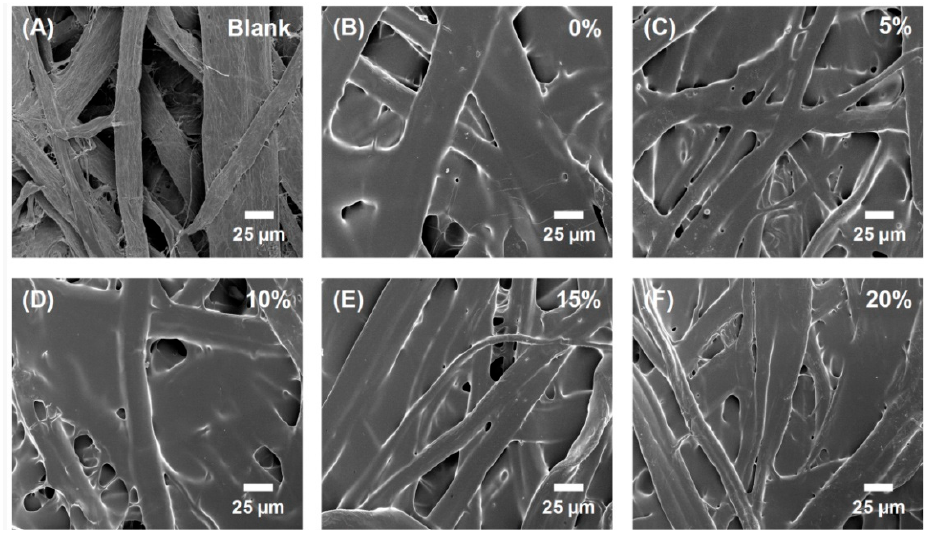
Figure 2. Electron micrographs of the surface of the blank paper ( A ) and paper coated with PVAc ( B ), and coated papers with copolymers containing different fractions of lignin ( C – F ).